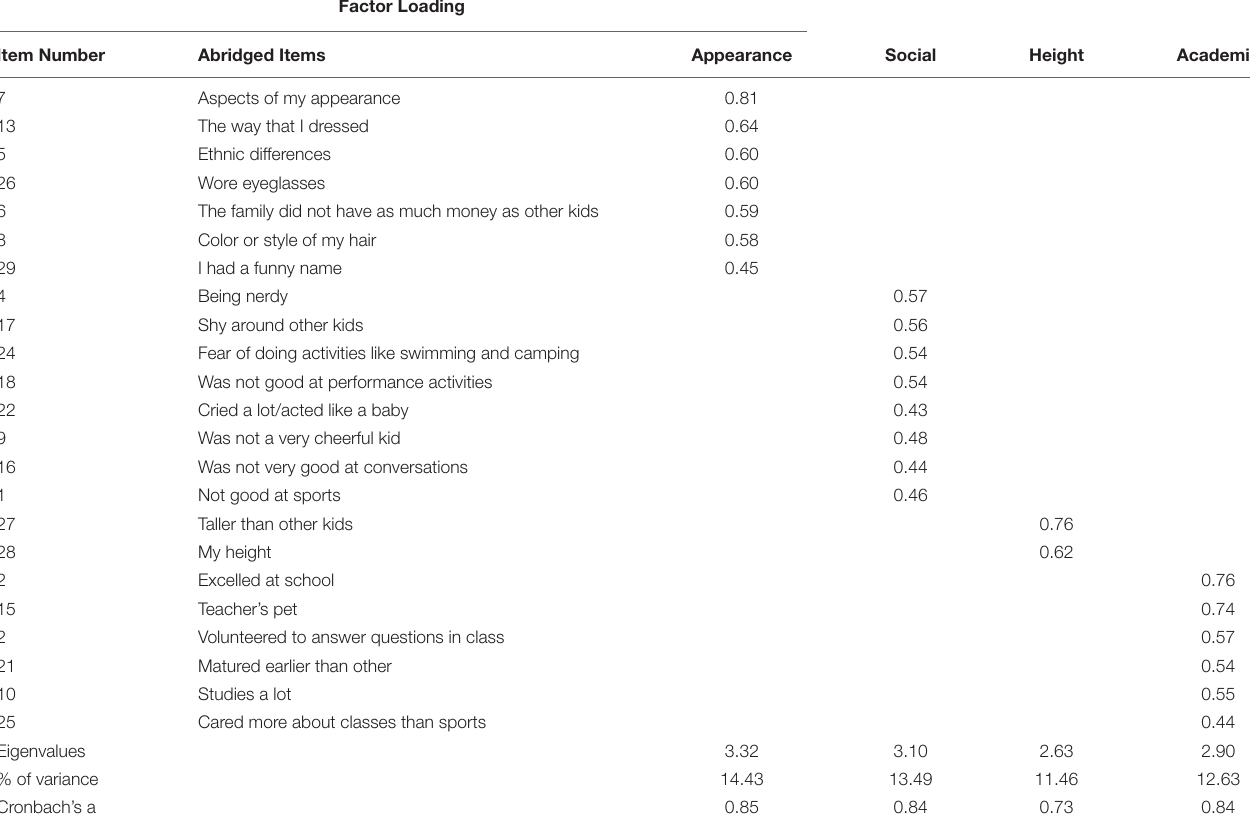
TABLE 3 | Factor analysis with varimax rotation method of the four-factor model of TQ-R ( N = 201).